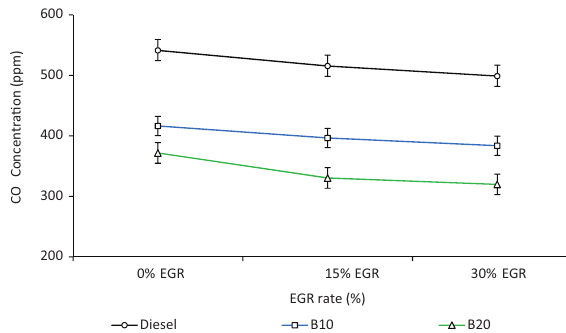
Figure 4. Effect of alcohol blends and different EGR rates on CO concentration in the exhaust gas under 1800 rpm